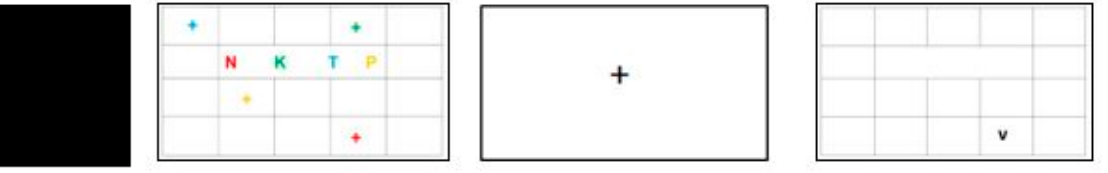
Figure 3. Picture sequence in MBT.